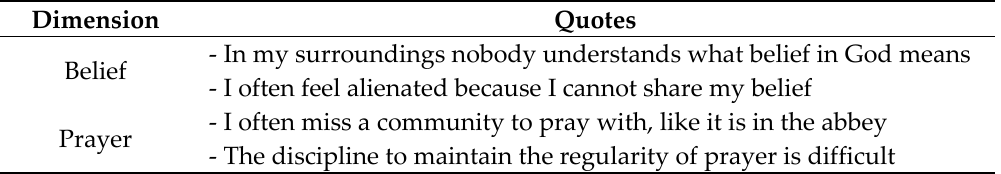
Table 13. Problems of ritual transfer—monastic context. Code Group